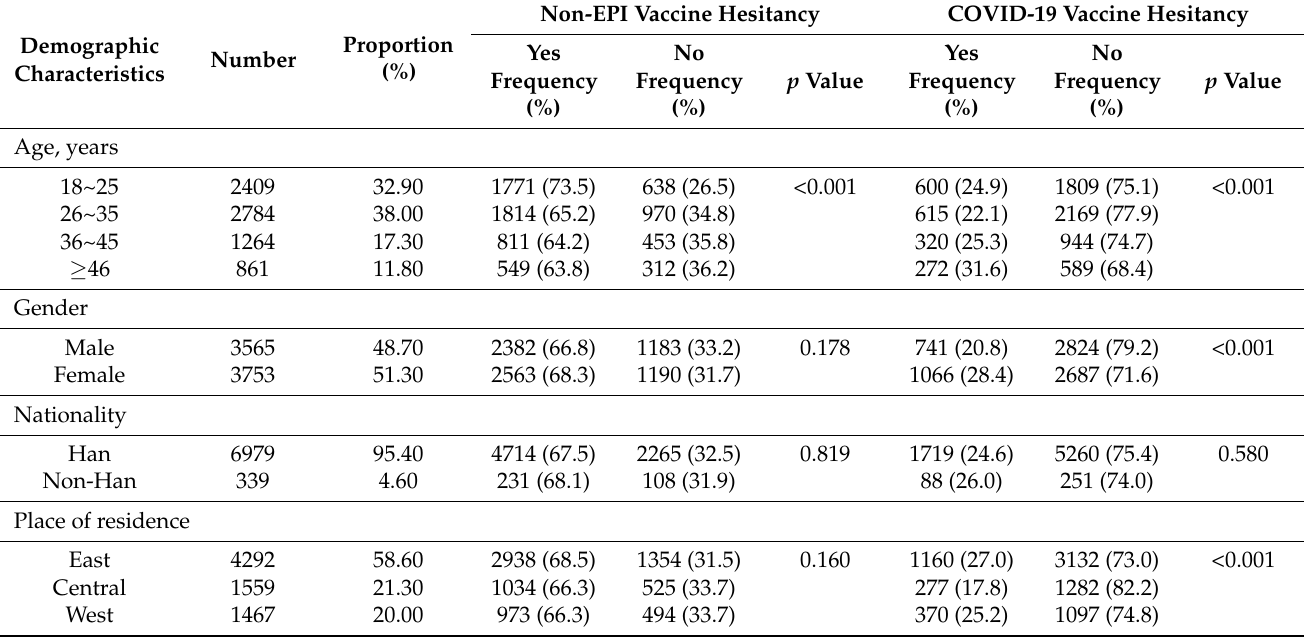
Table 2. Non-EPI vaccine hesitancy and COVID-19 vaccine hesitancy among participants with different demographics.